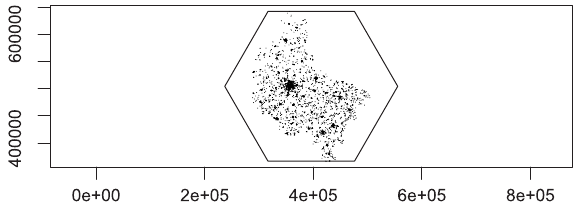
Fig. 3. Firms distribution in a hexagonal region. Source: own